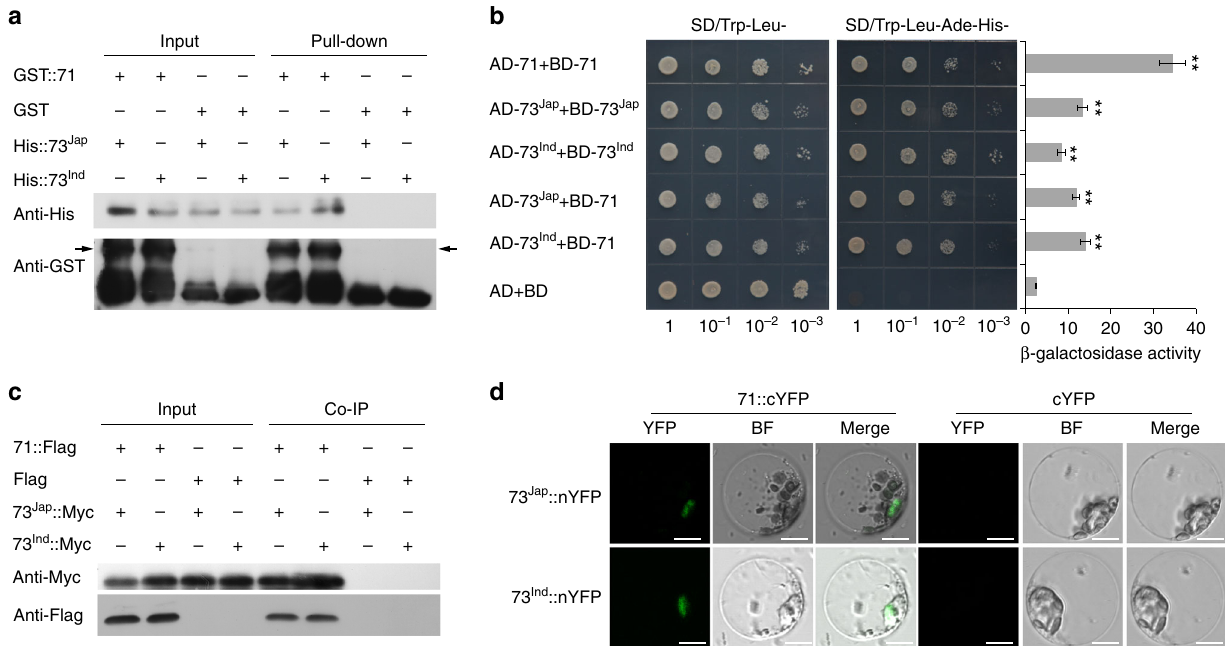
Fig. 2 In vivo and in vitro interaction assays between bZIP71 and bZIP73. a In vitro pull-down assay. Left panel (Input), 10% of input before precipitation; Right panel (Pull-down), af fi nity puri fi cation using glutathione S -transferase (GST) or GST::71 as bait, and polyhistidine (His)::73 Jap or His::73 Ind as prey. Anti-His and anti-GST antibodies were used to detect His and GST peptides, respectively. Black arrows indicate anti-GST detection of GST::71, and + and − indicate that ingredients shown at the left were added or not added, respectively, to the experiment. b In vivo yeast two-hybrid assay. Sequences of bZIP73 Jap , bZIP73 Ind , and bZIP71 were fused to both the pGADT7 activation domain (AD, prey) and the pGBKT7 binding domain (BD, bait), and then transformed into yeast. Shown are growth phenotypes of yeast transformants on selective media of SD/Trp-Leu- (left panel) and SD/Trp-Leu-His-Ade- (central panel, interaction). Physical protein – protein interactions were revealed by yeast colony sizes and quanti fi ed by β -galactosidase activity (right panel) using a liquid culture assay with three biological replicates. Error bar, standard deviation; ** p < 0.01, two-tailed t -test in comparison to the negative control, AD (pGADT7) + BD (pGBKT7). c In vivo co-immunoprecipitation (Co-IP) assay. Sequences of bZIP73 Jap and bZIP73 Ind were fused with a Myc tag, while bZIP71 were fused with a Flag tag. Vectors of 73 Jap ::Myc and 73 Ind ::Myc were transformed into transgenic rice lines expressing 71::Flag. Left panel (Input), before precipitation; Right panel (Co-IP), Anti-Myc and anti-Flag antibodies were used to detect Myc and Flag peptides, respectively. d In vivo bimolecular fl uorescence complementation assay. bZIP73 Jap and bZIP73 Ind were both fused with the N-terminal half of yellow fl uorescent protein (nYFP), while bZIP71 was fused with the C-terminal half of YFP (cYFP). BF, bright fi eld. Merge is overlay of YFP and bright fi eld images showing nuclear localization. Right panel, negative control. Scale bars, 10 µ